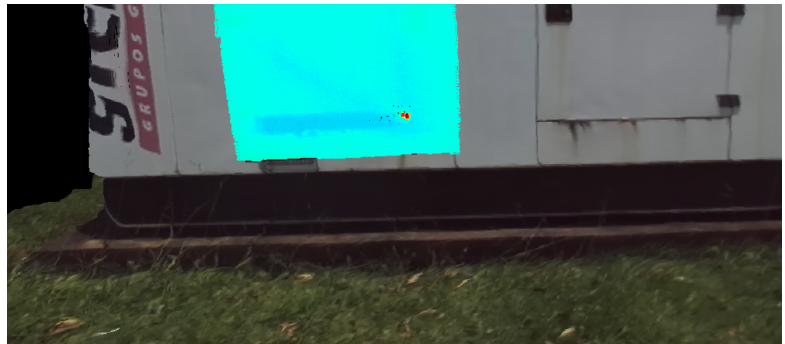
Figure 14. 3D model with false positive reading due to sunlight reflection.